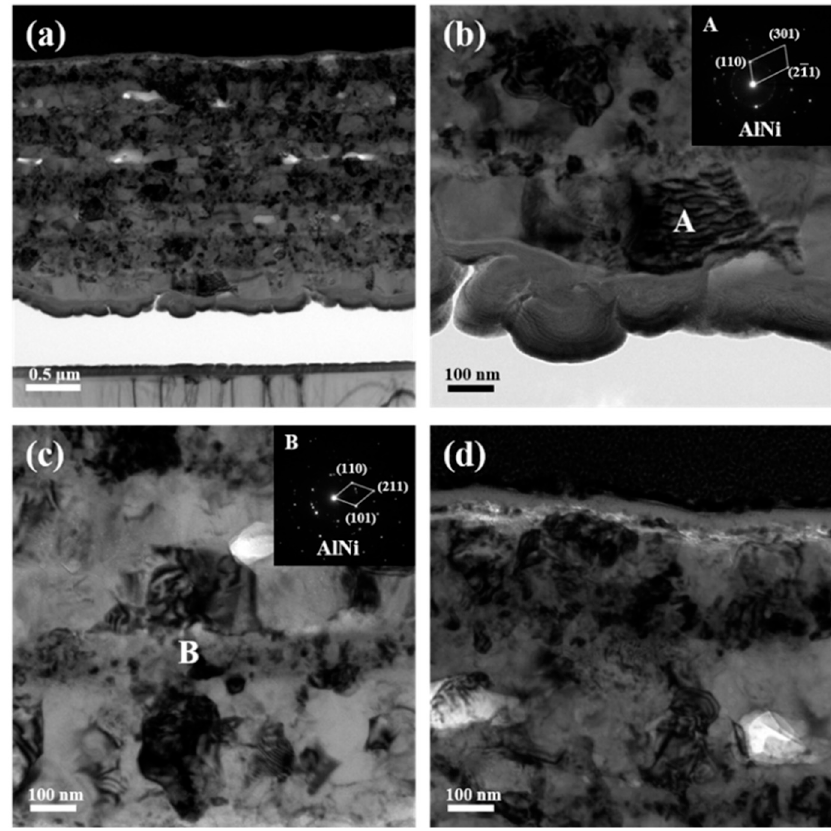
Figure 7. TEM images together with selected area electron diffraction patterns of the ATNT foil after annealing at 773 K for 3 h: ( a ) the whole morphology; ( b ) the bottom region; ( c ) the middle region; ( d ) the top region.